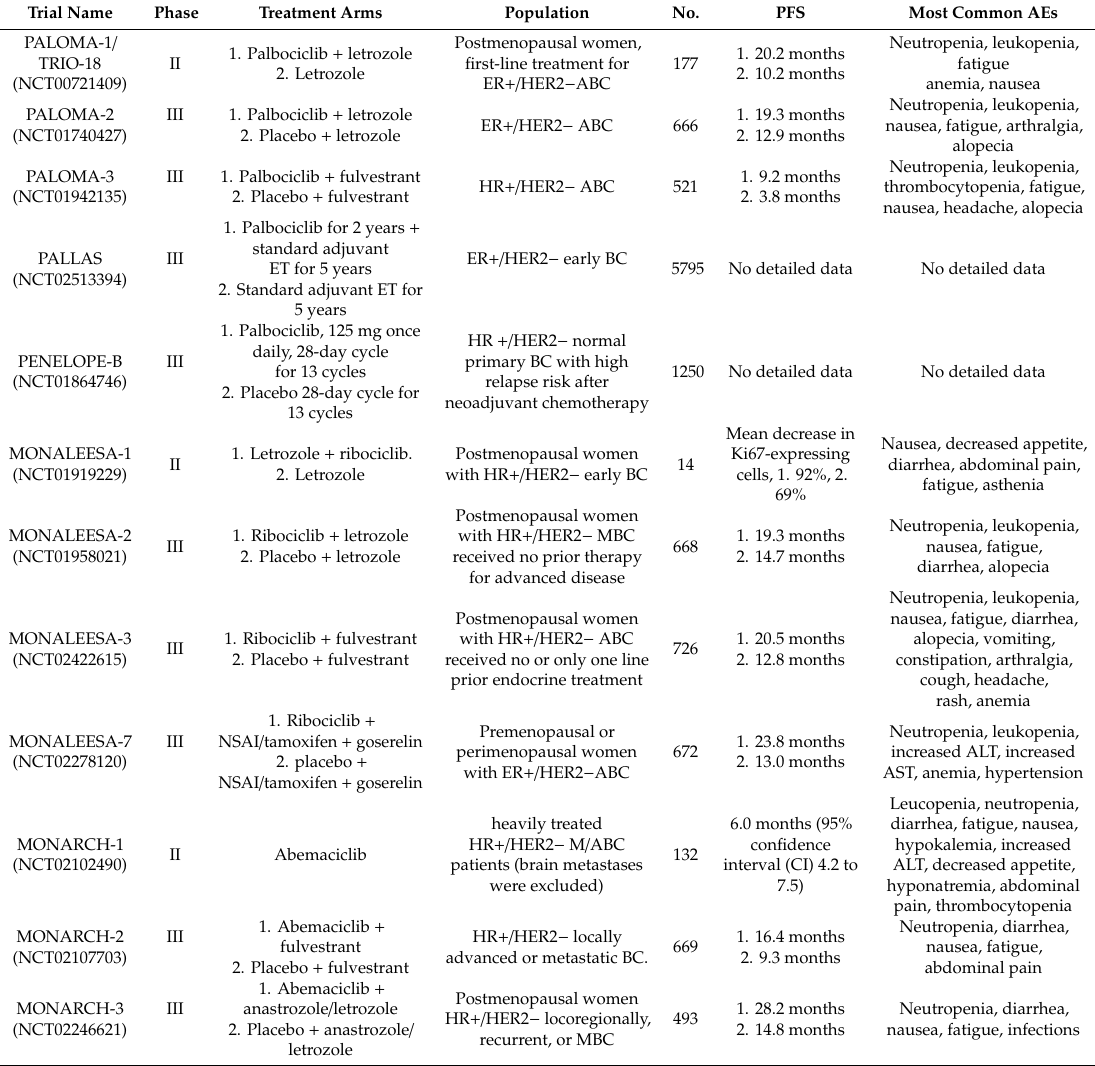
Table 2. Reported clinical trials assessing CDK4 / 6 inhibitors in